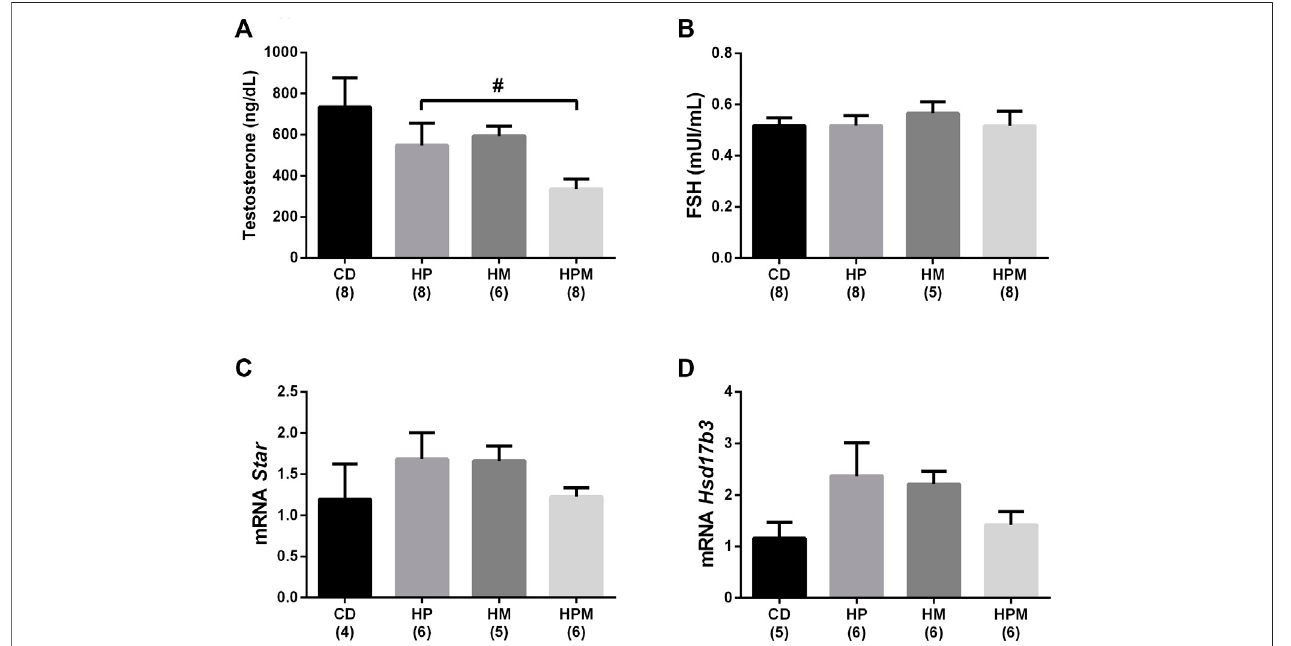
FIGURE 8 | Serum levels of sex hormones and gene expression of testicular steroidogenic enzymes in male rat offspring from progenitors fed on high-fat high- sugar diet. Mean ± SEM; symbols indicate signi fi cant difference caused by parental diet ( p < 0.05): # statistically signi fi cant by the effect of paternal diet. H: high-fat and high-sugardiet;CD(controlpaternalandmaternaldiet),HP(Hpaternaldietandcontrolmaternaldiet),HM(Hmaternaldietandcontrolpaternaldiet)andHPM(Hpaternal and maternaldiet). (A) :serumtestosterone: n =6 – 8; (B) :serumfolliclestimulatinghormone(FSH) ( n =5 – 8); (C) : steroidogenicacuteregulatoryprotein ( Star )( n =4 – 6); (D) : 17 β -hydroxysteroid dehydrogenase 3( Hsd17b3 ) ( n = 5 – 6).